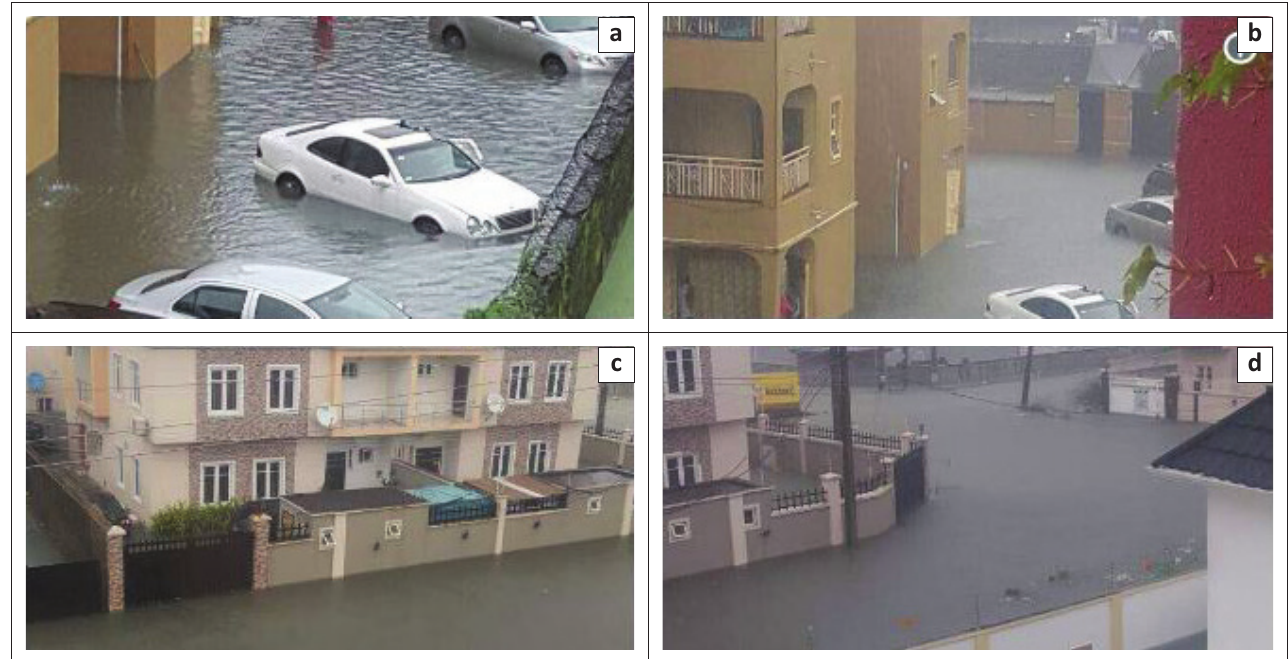
FIGURE 1: Some flooded buildings in July 2017 at Victoria